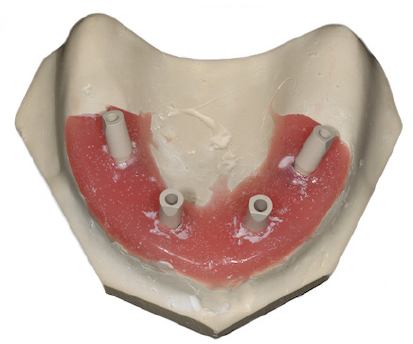
Figure 1. Implant level intraoral scan bodies tightened on the reference model.